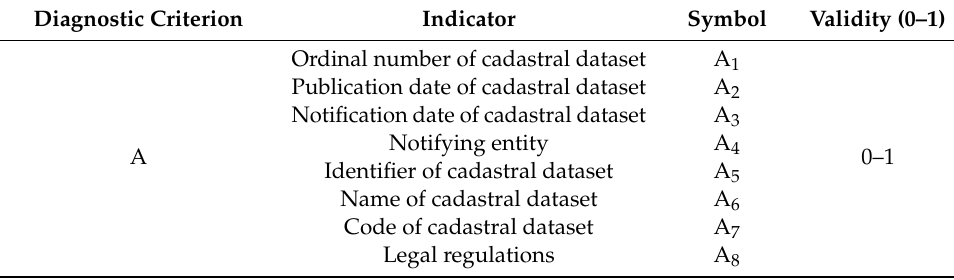
Table 2. Technical and Legal